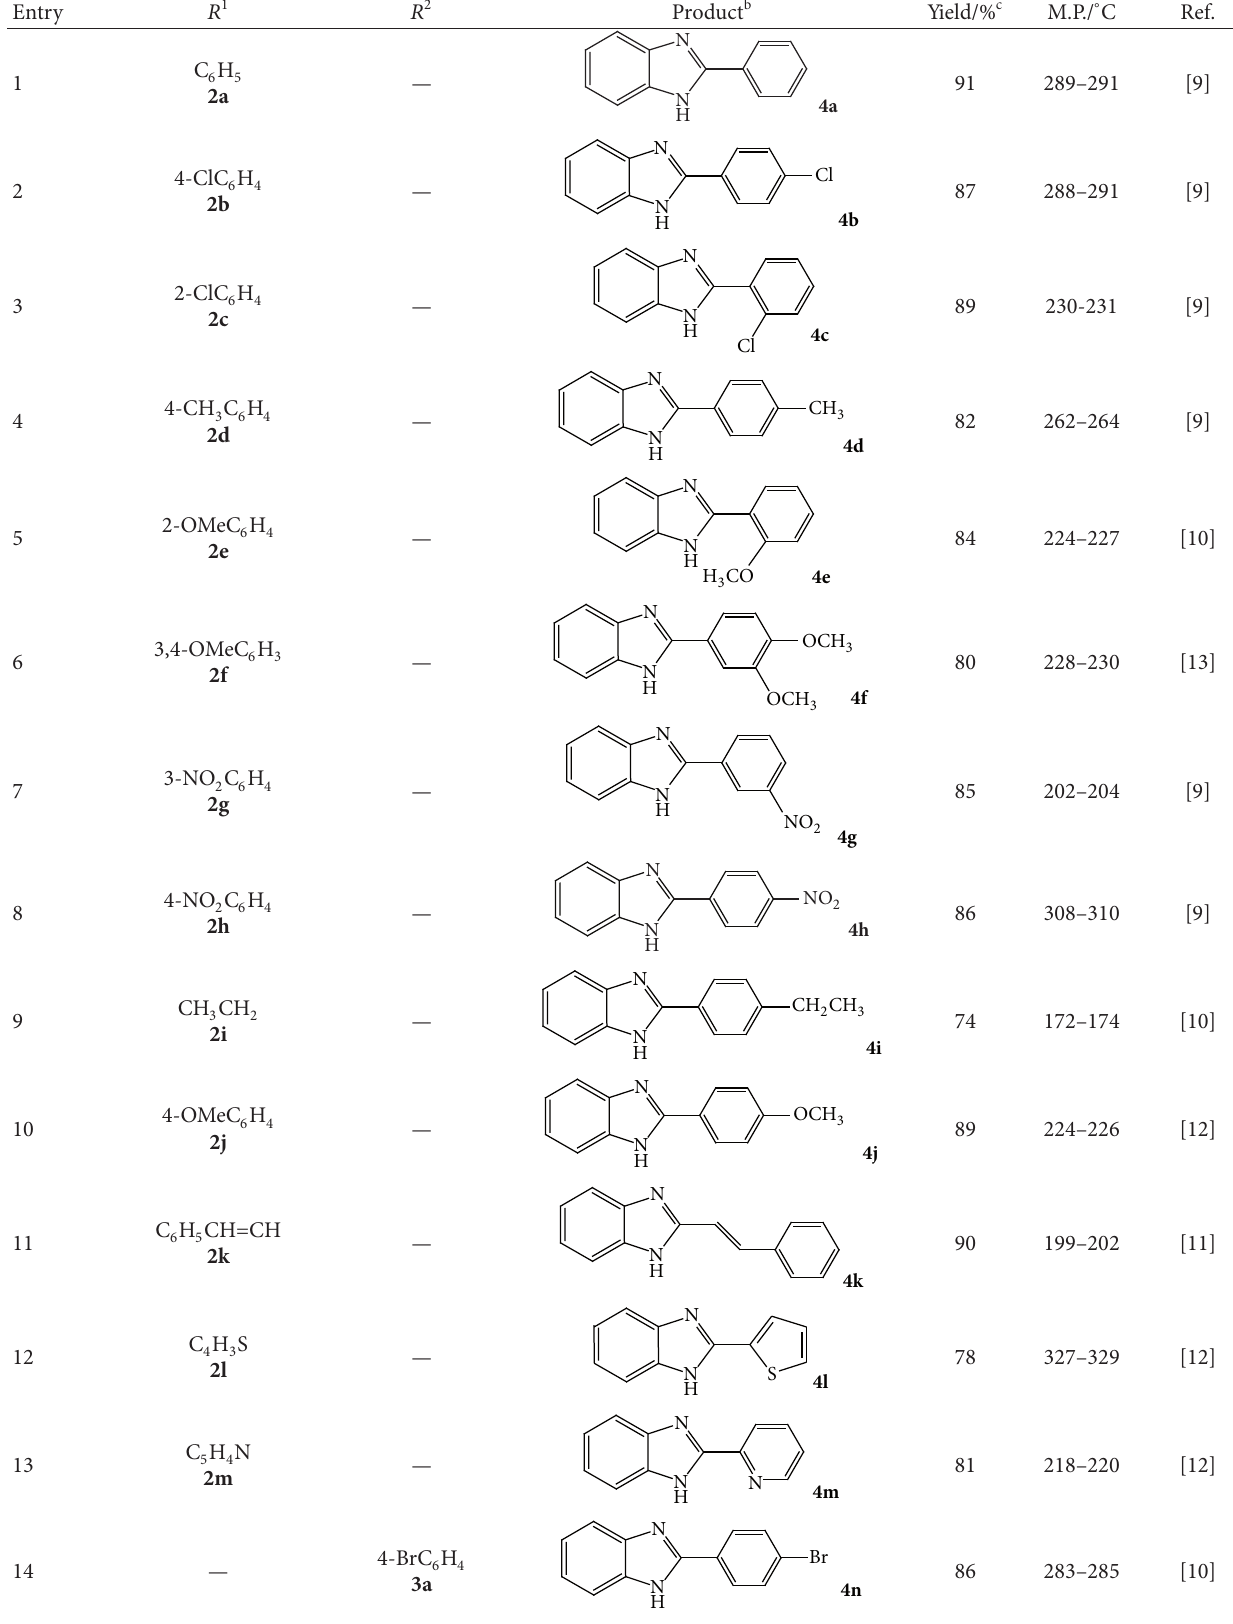
T 2: Synthesis of benzimidazoles catalyzed by silica sulfuric acid a